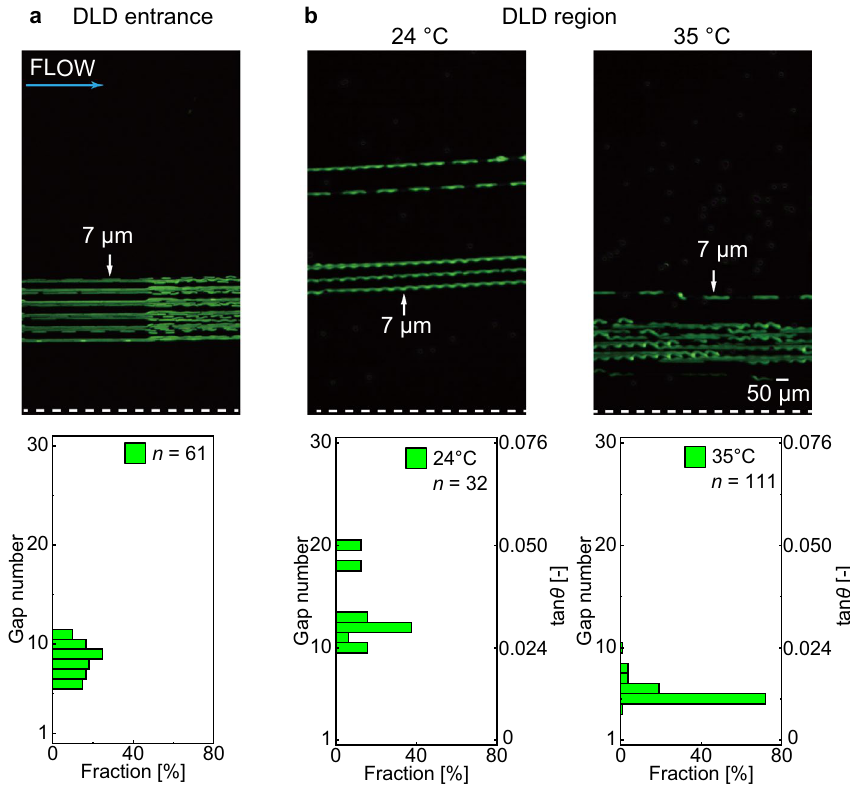
Figure 7. Thermally-switchable particle trajectories. ( a ) Trajectories and spatial distributions of the 7-μm beads (green) in the focused stream at the DLD entrance. ( b ) Trajectories and spatial distributions of the 7-μm beads flowing downstream (20th DLD section) in displacement mode at low temperature (24 °C, left) and in zigzag mode at high temperature (35 °C,